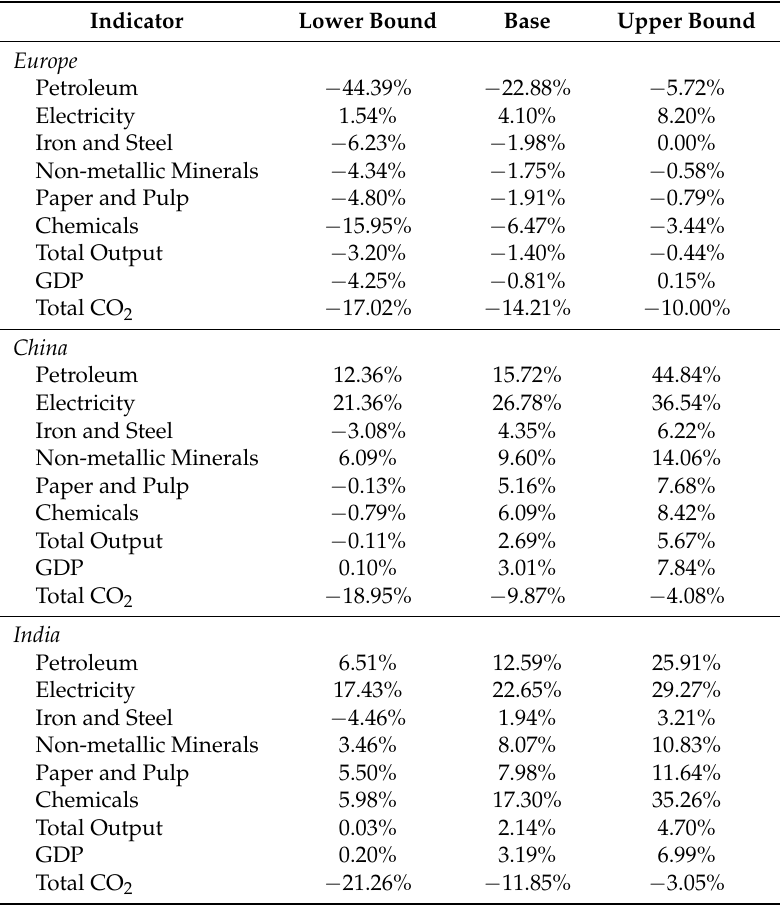
Table A5. Upper and lower bound of simulation results in sensitivity analysis for main indicators in Europe, China and India. Indicator Lower Bound Base Upper